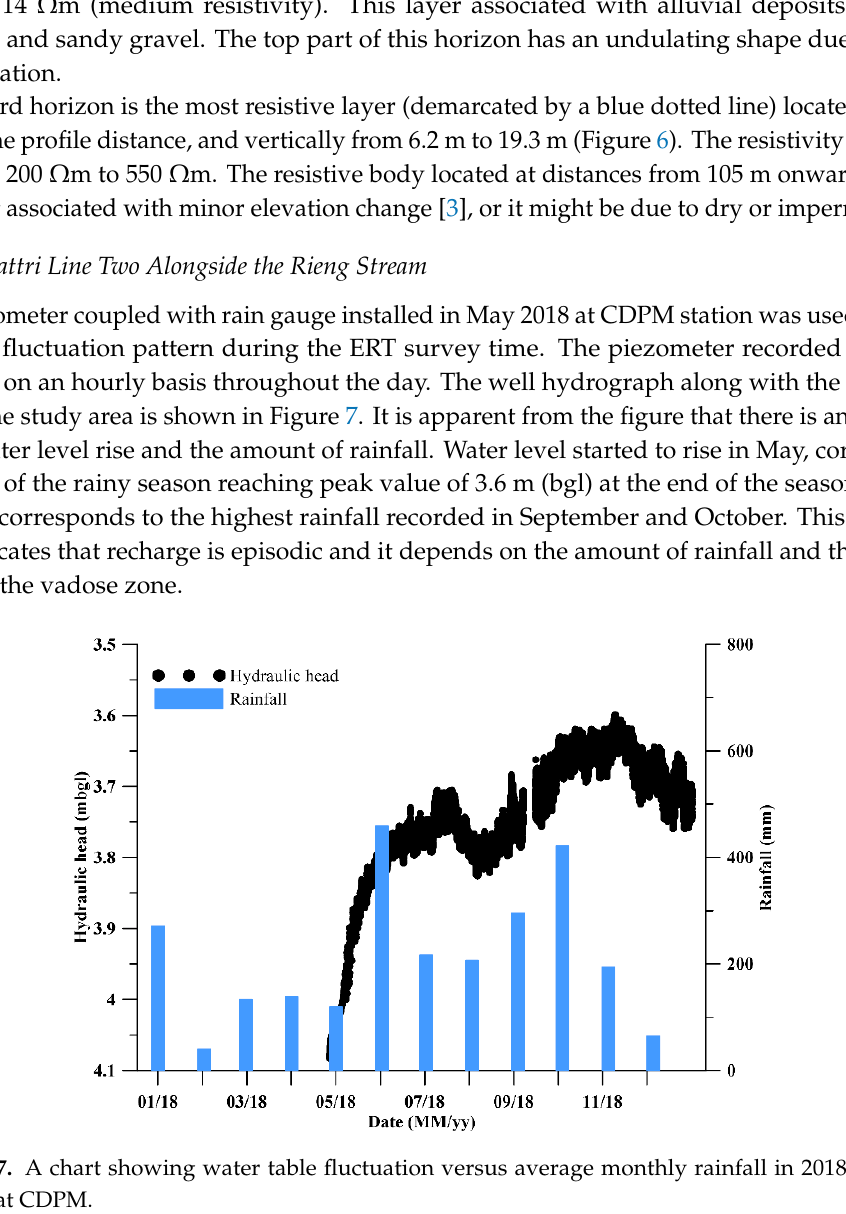
Figure 6. Electrical resistivity tomography of line one. The red arrow indicates the location of resistivity log at 81 m distance: ( a ) 30 March 2018; ( b ) 14 June 2018; ( c ) 05 September 2018. RMS = root mean squared error; L2-norm = the sum of the squared weighted data errors.